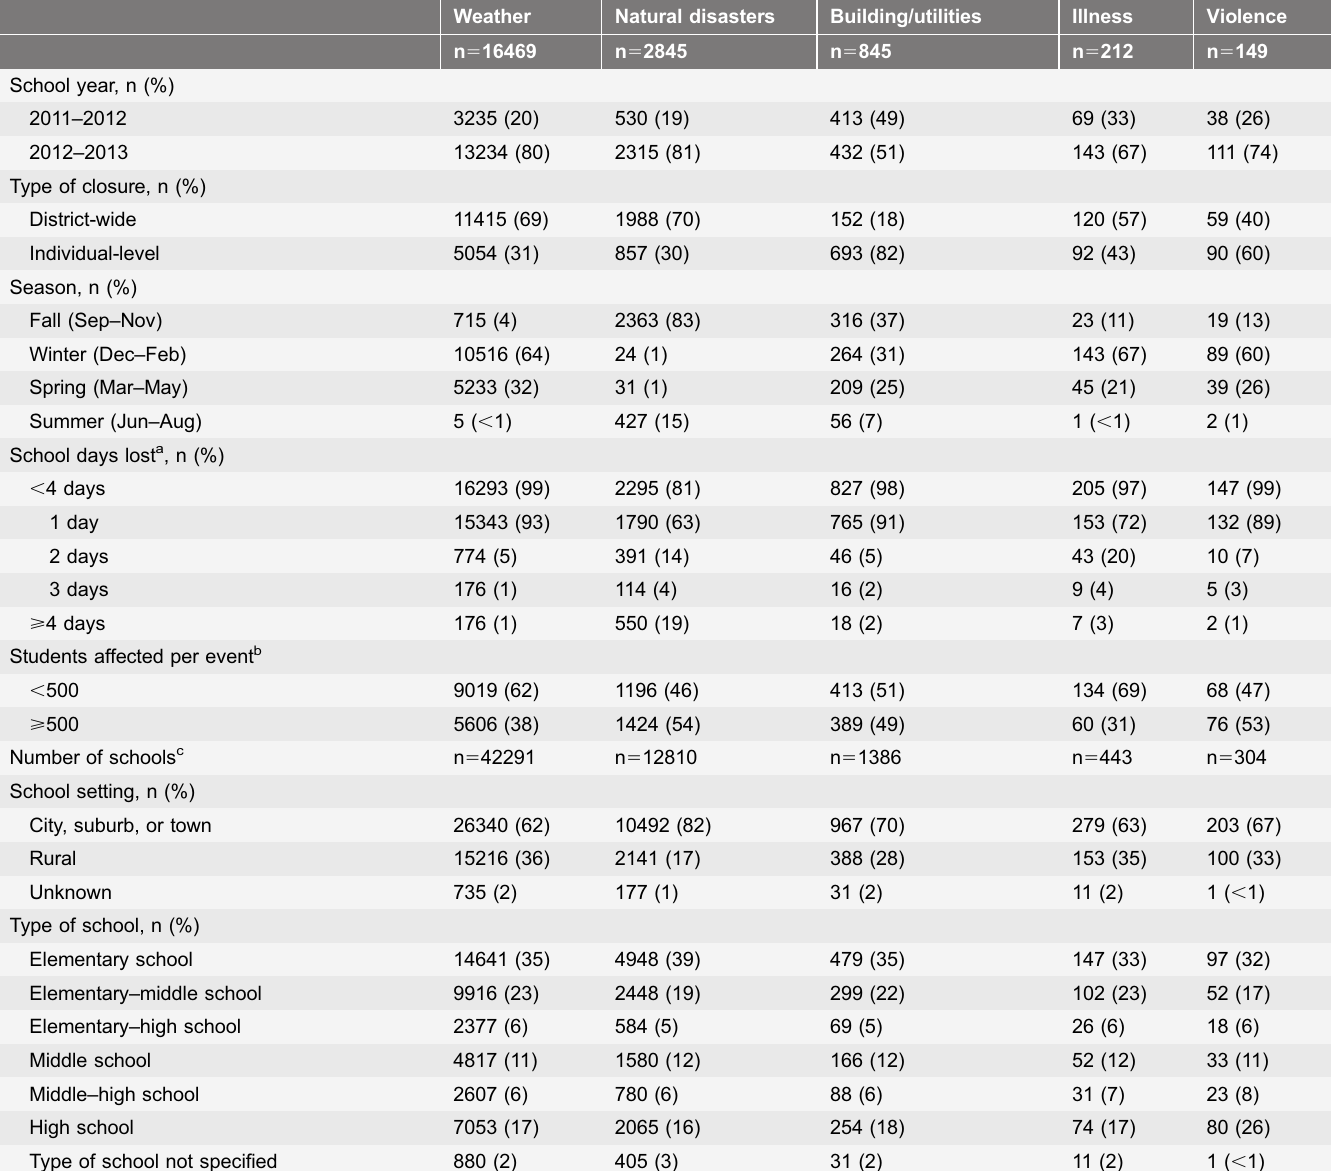
Table 2. Selected characteristics of school closure events and schools by reason for school closure — United States,